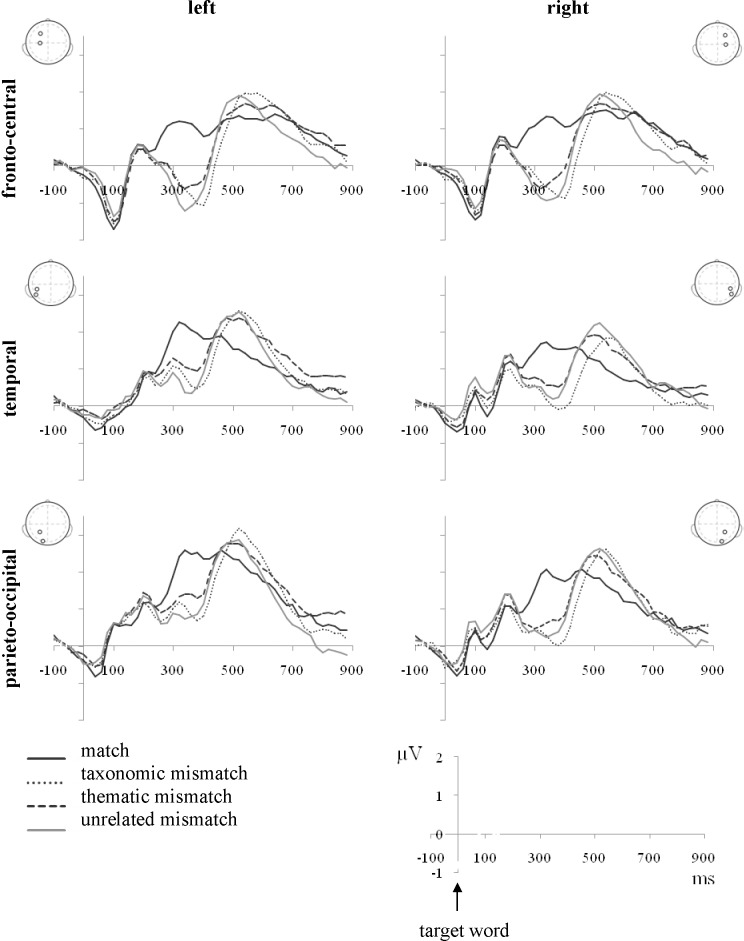
Average ERP waveforms time-locked to the presentation of targets in each of the four match type conditions for six zones.